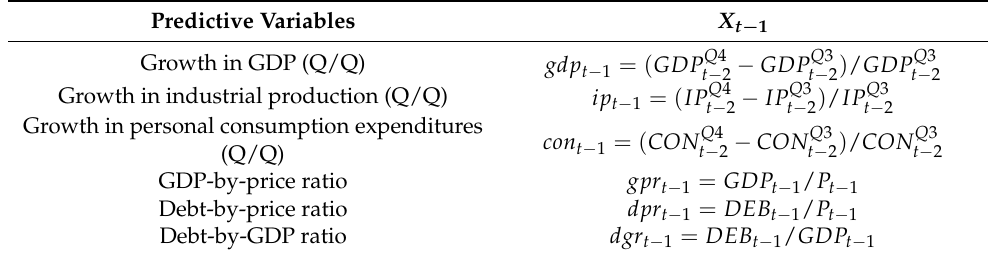
Table 1. Time-lagged predictive variables X t − 1 related to government debt and economic growth. Q/Q is the quarter-over-quarter growth rate from the third to the fourth quarter of a year, GDP is the nominal gross domestic product, IP the industrial production index, CON nominal personal consumption expenditures and DEB the total government